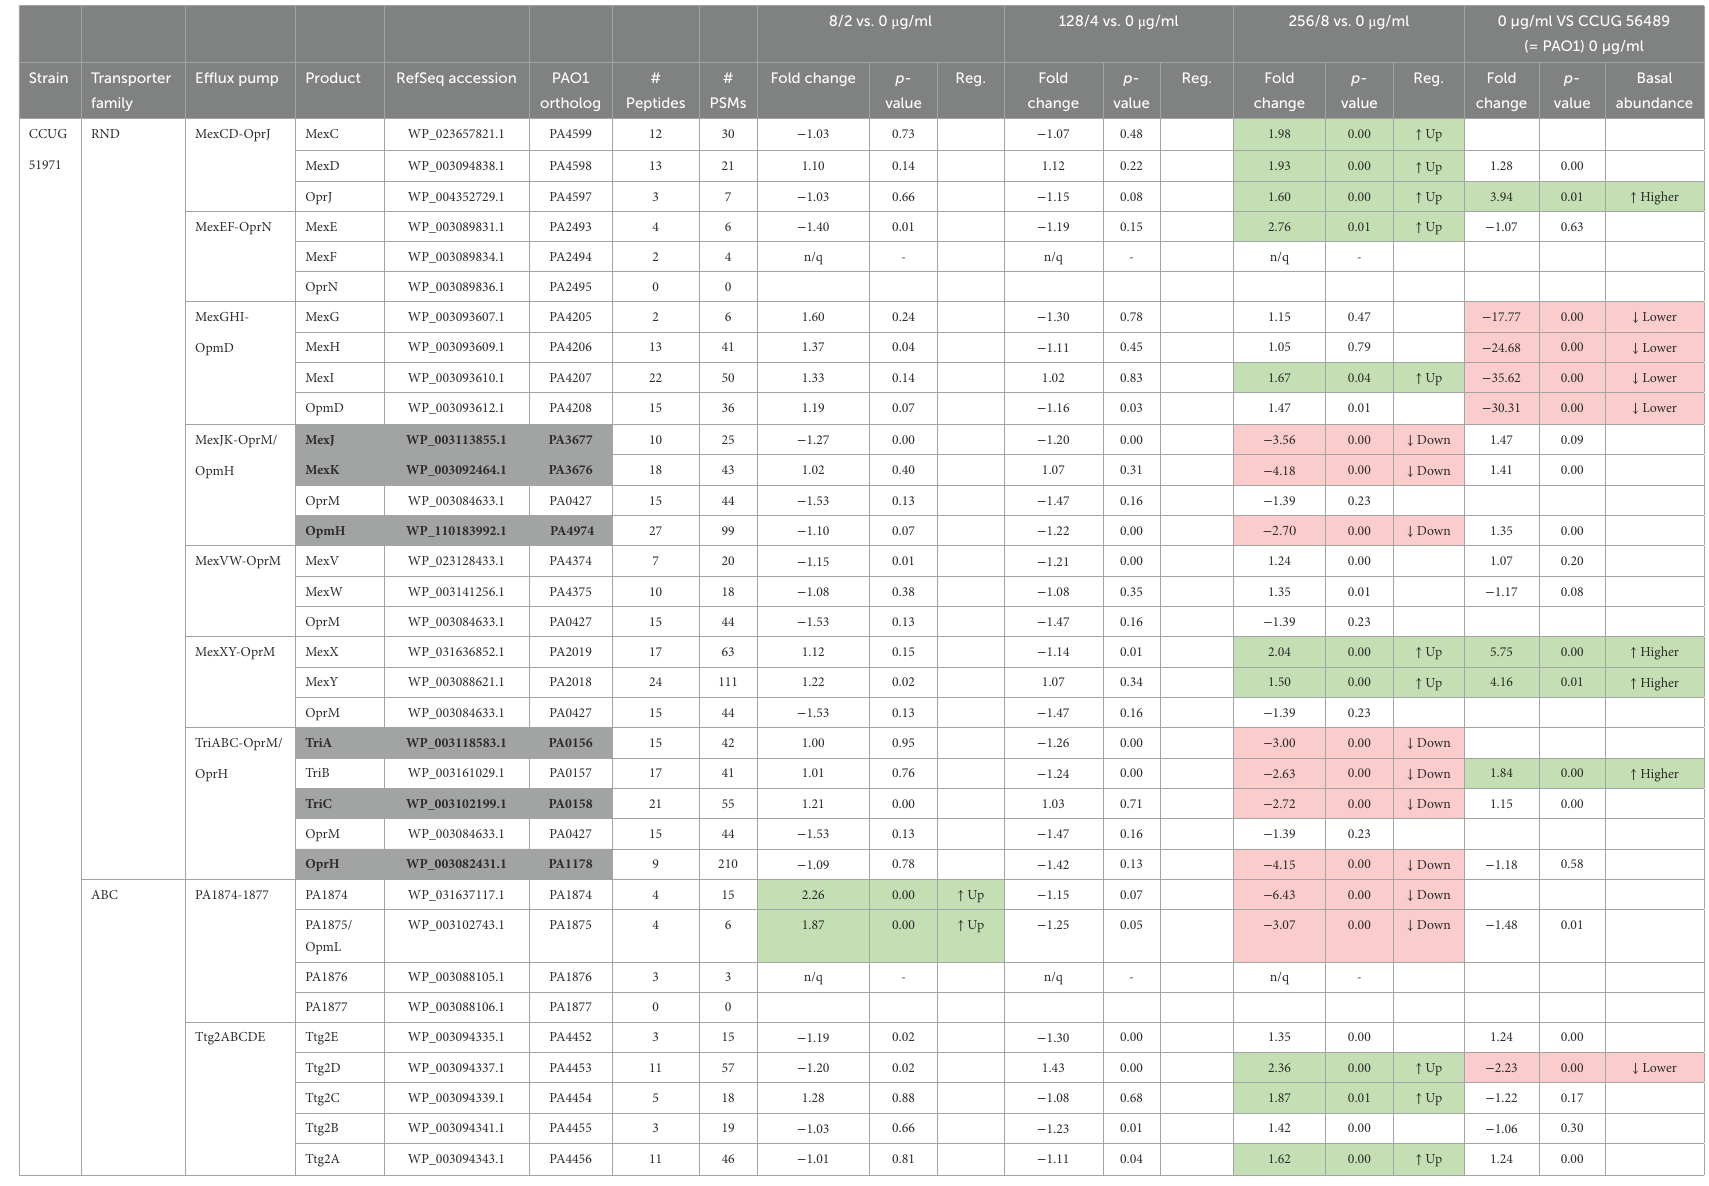
TABLE 4 Characterized drug efflux pumps of Pseudomonas aeruginosa CCUG 51971 and CCUG 70744 with differentially regulated